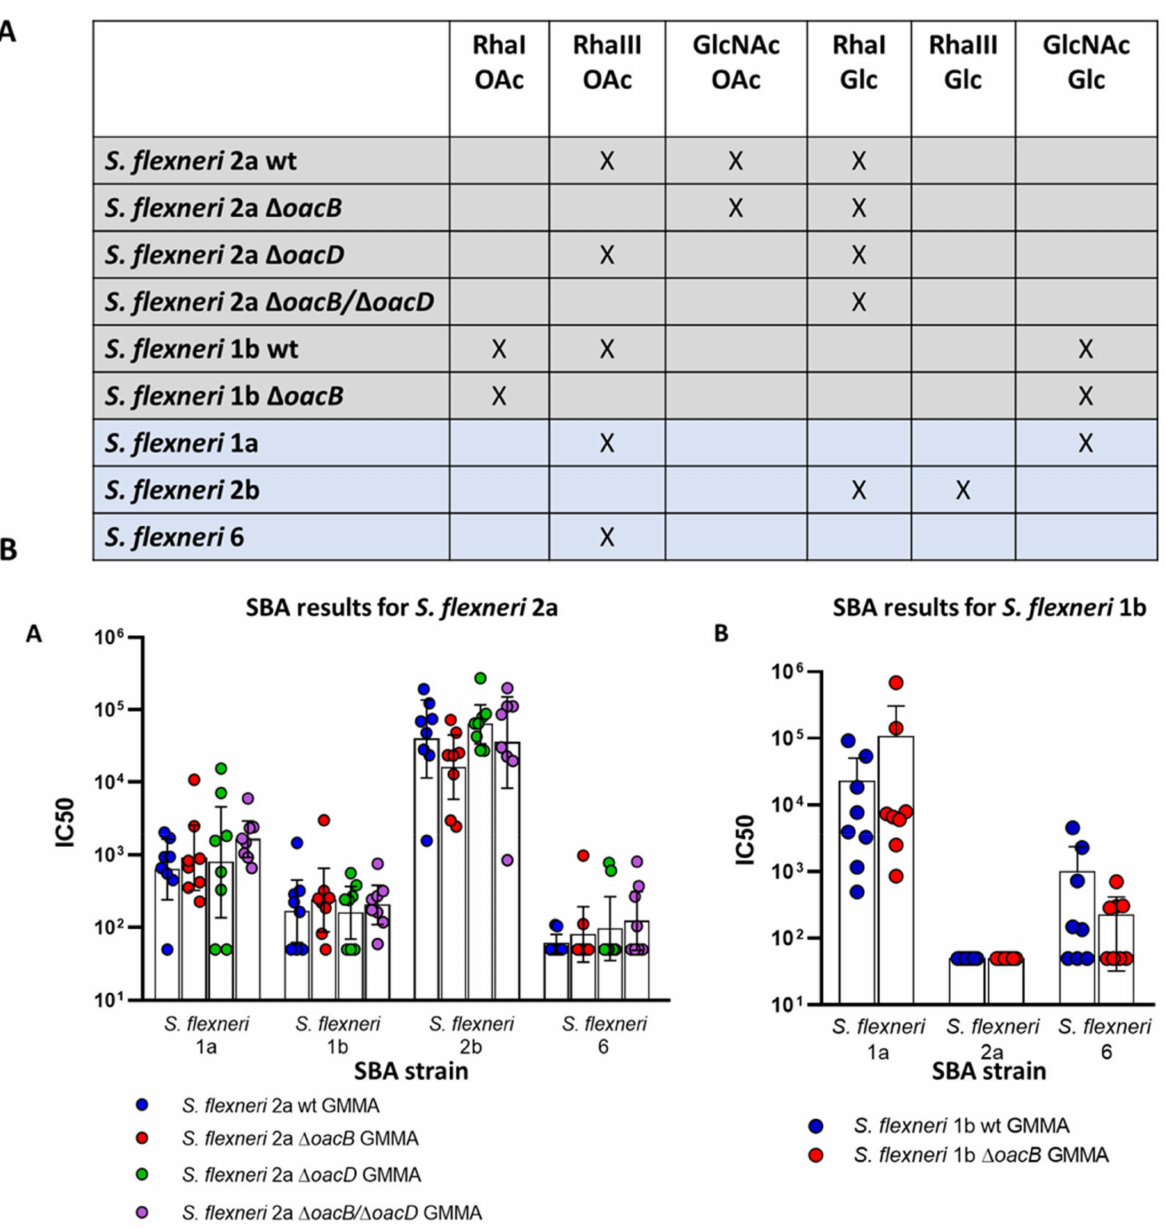
Figure 4. SBA results against heterologous strains. ( A ) Table showing OAg epitopes shared among the Shigella serotypes used in this study, including GMMA producing strains of S. flexneri 2a and 1b (grey rows) and S. flexneri serotypes used to check cross-reactivity in SBA (blue rows). ( B ). Summary graphs of L-SBA titers against the heterologous S. flexneri strains (X axis) reporting individual IC 50 levels (dots) and geometric mean (bars). Sera tested in this assay were raised by immunizing mice with 0.5 µ g of GMMA (OAg dose) from S. flexneri 2a ( B-A ) and S. flexneri 1b ( B-B ). Statistics performed by applying a Kruskal–Wallis test among the differently O-acetylated GMMA is not reported as it resulted in non-significant differences for all the strains